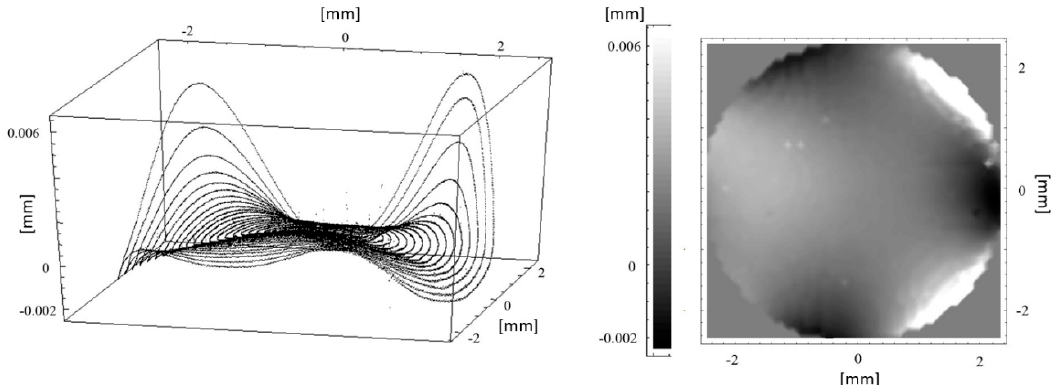
Figure 2. Surface residuals with regard to the nominal surface: plotted on the concentric measuring path ( left ), contour plot ( right ).